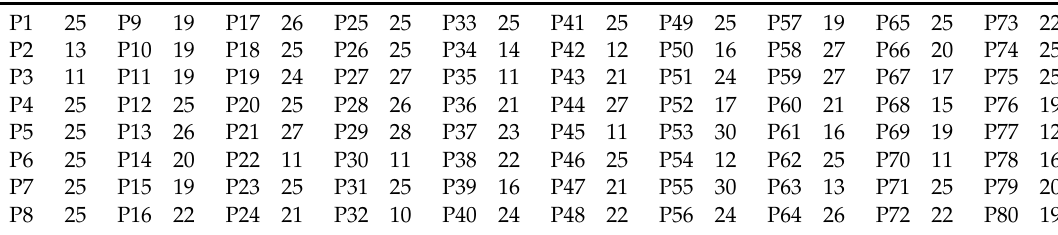
Table 5. Workloads of each personnel with manual scheduling.